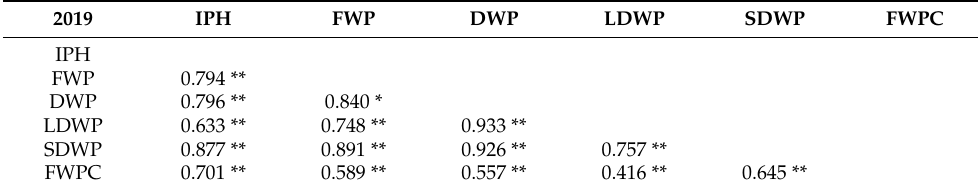
Table 2. Correlation coefficients among the 6 traits in the 302 ramie accessions (2019).